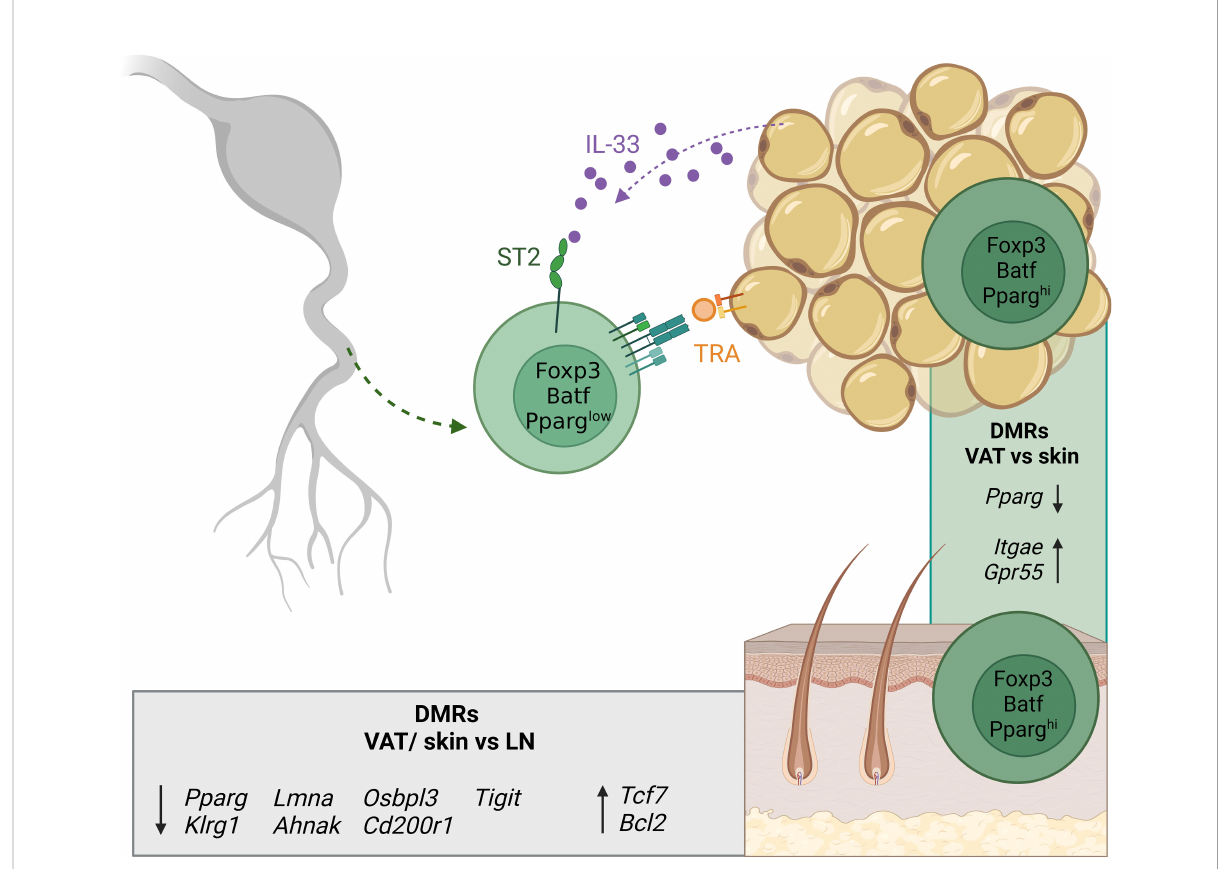
FIGURE 3 Overview of tissue Treg cell epigenetics in tissues. Tissue Treg precursors leave SLOs already expressing low levels of PPAR g and are recruited to the tissues (here exempli fi ed by VAT) via soluble factors like IL-33 and via TRA recognition. In the tissue, the tissue Treg-speci fi c methylation pattern is completed. The grey box shows DMRs of Treg cells from VAT and skin versus lymph node-derived Treg cells. The green box shows DMRs between VAT and skin Treg cells. Treg, regulatory T cell; SLOs, secondary lymphoid organs; VAT, visceral adipose tissue; LN, lymph node; TRA, tissue-restricted antigen; DMRs, differentially-methylated regions. Created with